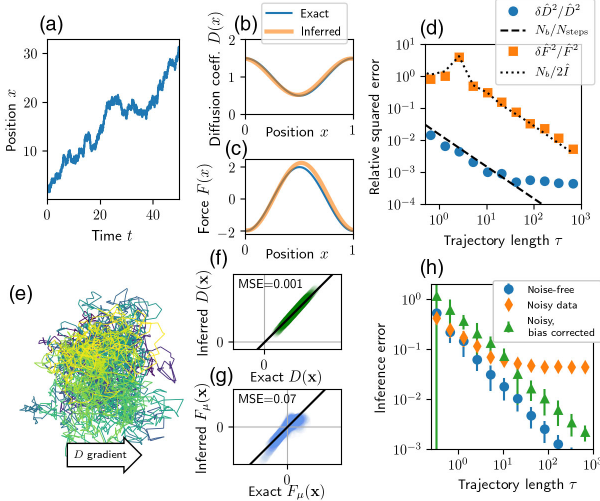
FIG. 8. Stochastic inference of inhomogeneous diffusion and forces. (a) A trajectory of a 1D ratchet model with F ð x Þ ¼ F 0 cos ð 2 π x Þ and D ð x Þ ¼ 1 þ a cos ð 2 π x Þ , with periodic boundary conditions. (b),(c) For the trajectory presented in (a), inferred and exact diffusion coefficient [using Eq. (12)] and force field [using Eq. (15)] as a function of the position. We use a first-order Fourier basis to infer both force and diffusion. (d) Analysis of the convergence of the diffusion (blue) and force (orange) estimators as a function of the trajectory duration for the process presented in (a). The dotted and dashed black lines are the self-consistent estimates for the squared error, respectively, for the diffusion and the force. The plateau for the diffusion inference is due to the finite time step. (e) A trajectory of a minimal 2D model, an isotropic harmonic trap at equilibrium F μ ð x Þ ¼ − D μν ð x Þ x ν in a constant gradient of isotropic diffusion D μν ð x Þ ¼ ð 1 þ a ρ x ρ Þ δ μν . (f),(g) Inferred versus exact diffusion coefficient [using Eq. (12)] and force components [using Eq. (15)] along trajectory (a). A linear polynomial basis is used to fit the diffusion coefficient and a quadratic basis to fit F μ . (d) Convergence of the diffusion projection estimator (normalized by the average diffusion tensor) to its exact value for the process shown in (a). Circles, using Eq. (12); diamonds, using Eq. (12) in the presence of time- uncorrelated measurement noise; triangles, using the bias- corrected local estimator. Error bars represent the standard deviation over 64 samples. Details and parameters in Appendix